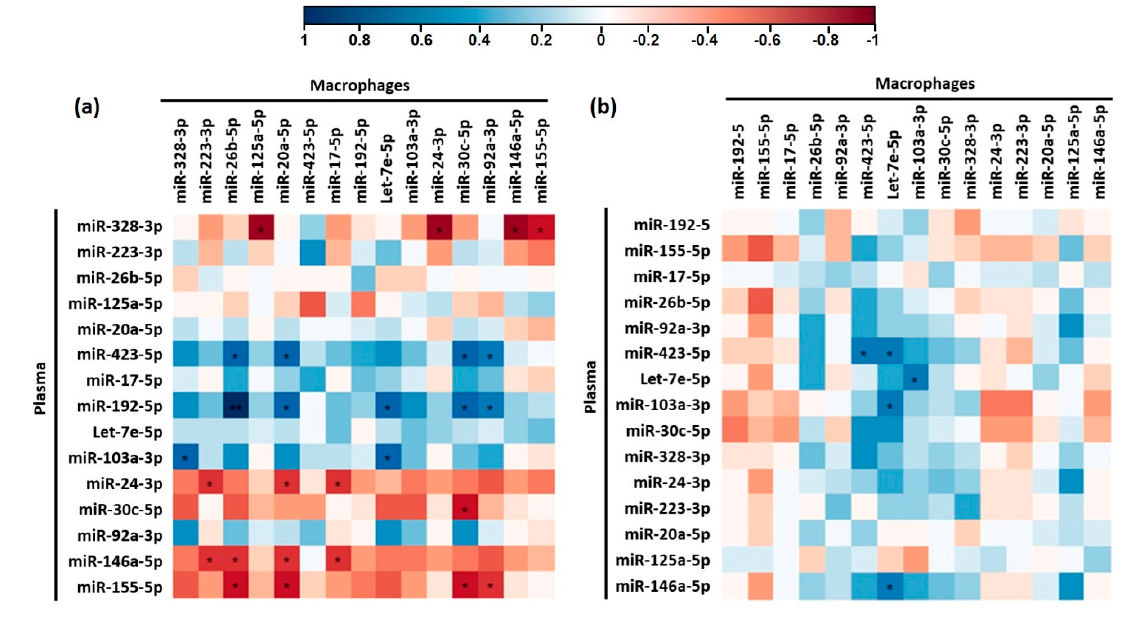
Figure 4. Heat map correlation plots of plasma and macrophage microRNAs modulated beer ( a ) and non-alcoholic beer ( b ). Correlation was calculated by Tau Kendall test. * p < 0.05. Blue cells represent positive correlations while red cells represent negative correlations. The intensity of the colour represents the strength of the correlation according to the indicated colour key.